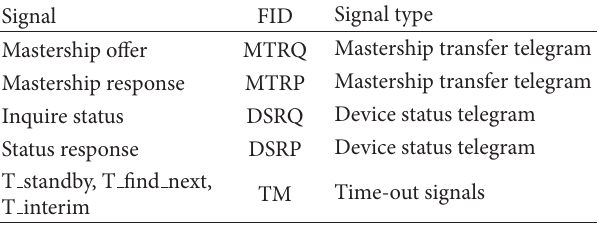
Table 3: Places and their descriptions in the top